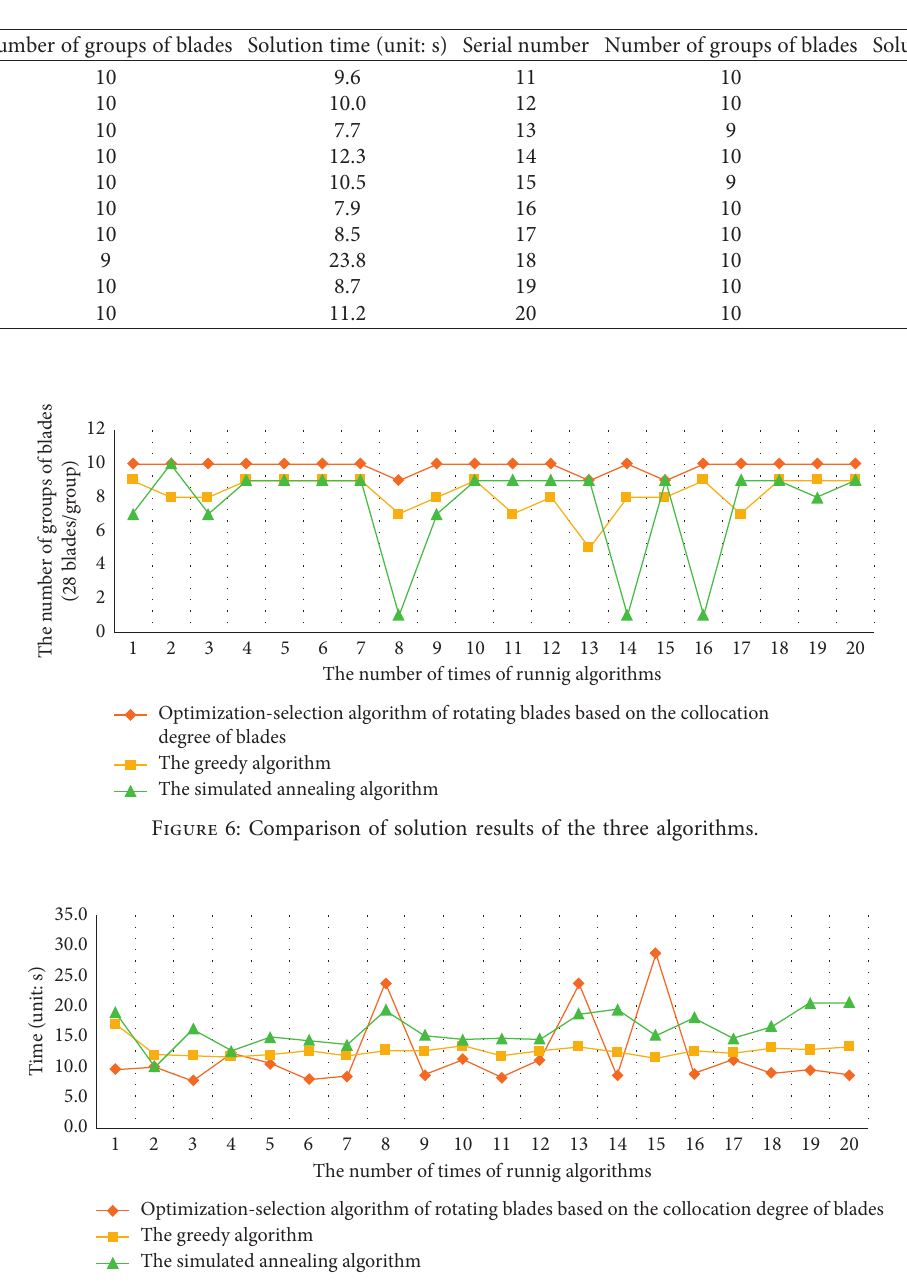
Figure 7: Comparison of solution time of the three